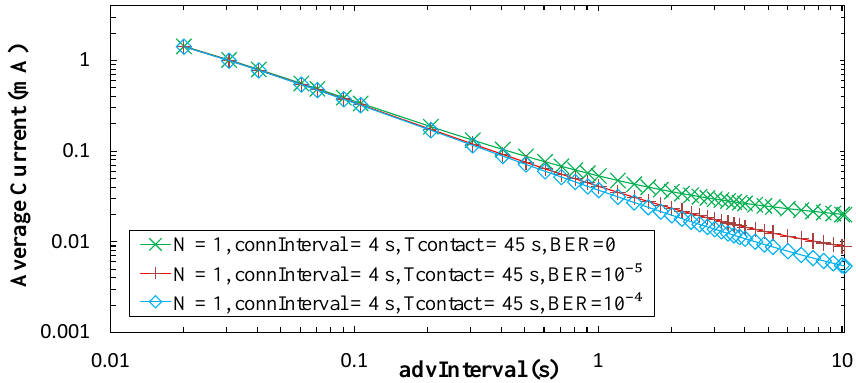
Figure 15. Average current consumption of the sensor node in the connection-based approach, for a time between contacts of one day, for N = 1, Tcontact = 45 s, and connInterval = 4 s, as a function of advInterval , and for different BER values.